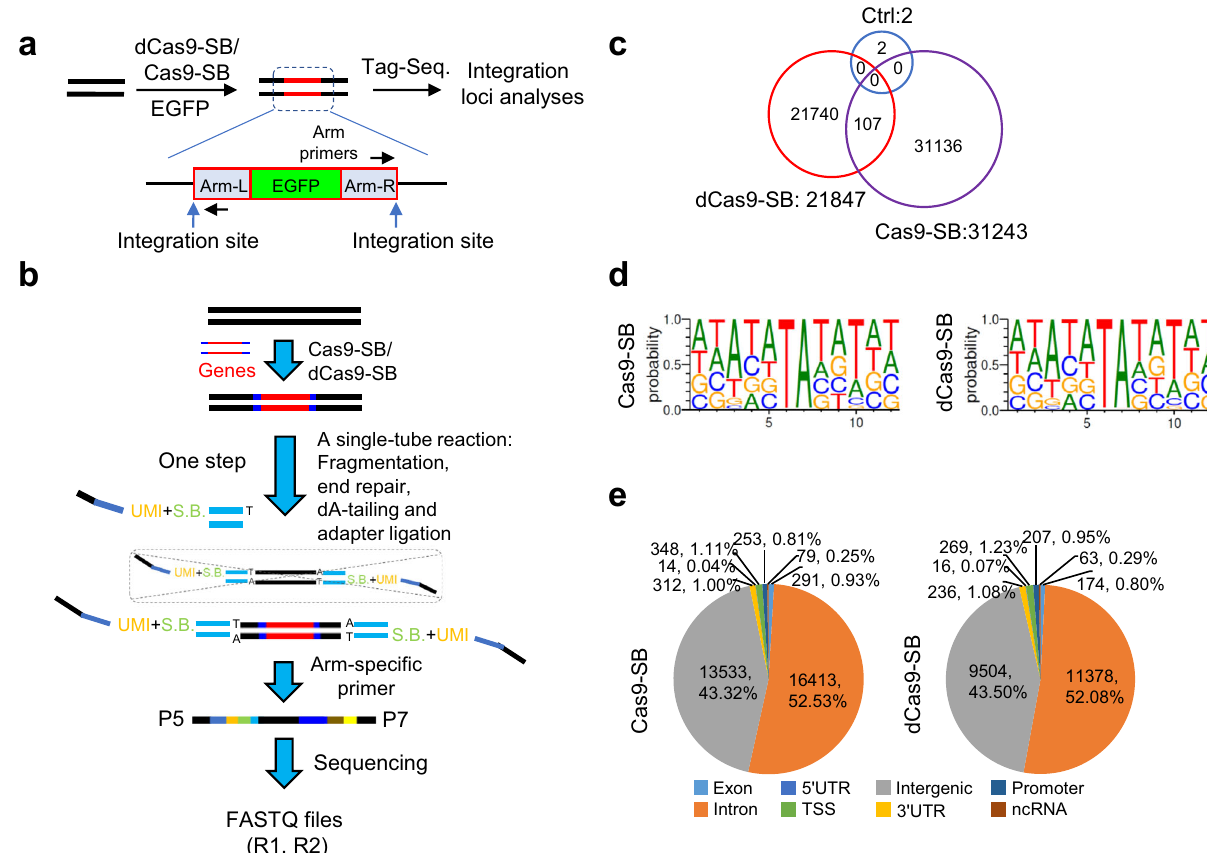
Fig. 6 Tag-seq pro fi les the integration loci of exogenous genes induced by transposons. a Diagram showing the use of Tag-seq to discover integration sites of EGFP induced by Cas9/dCas9 and Sleeping Beauty transposase fusion proteins. Arm-L/Arm-R, the left/right homology arm sequences. UMI, unique molecular index, S.B., sample barcode. b Work fl ow for construction of the library of Tag-seq for detection of the integration locations induced by Sleeping Beauty transposons. c Venn diagram showing the overlapping numbers of the insertion sites among the control, Cas9-SB, and dCas9-SB by Tag- seq. Ctrl, genomic DNA from blank-transfected cells was analyzed with Tag-seq; Cas9-SB/dCas9-SB, genomic DNA from cells transfected with the plasmids coding Cas9/dCas9-SB and the donor plasmid containing the SB-transposon-arm- fl anked EGFP-expression cassette was analyzed with Tag-seq. d Sequence logos obtained via DNA sequences near the cleavage sites (±5 bp) identi fi ed by Tag-seq. e Distributions of the integrated locations in Tag-seq data analysis pipeline . A detailed description and the source code for Tag-seq data analysis pipeline are available at github (https://github.com/ zhoujj2013/Tag-seq) and Zenodo (https://doi.org/10.5281/zenodo.4679460). FACS analysis . FACS assays were performed for testing the EGFP insertion ef fi - ciency induced by transposase. HEK293T cells were harvested 21 days for complete degradation of EGFP plasmid after a three-day puromycin selection starting the next day post-transfection. EGFP expressing cells were gated by FITC channel and data were analyzed with the FlowJo software V7 (TreeStar, USA).